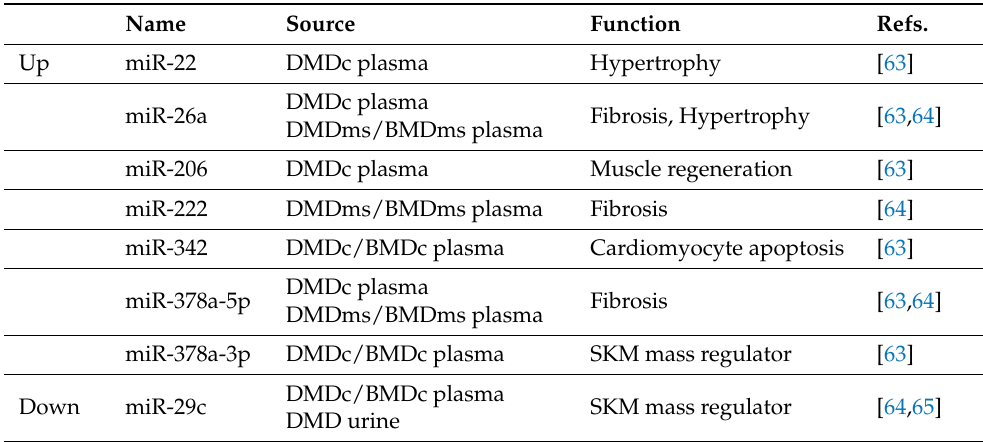
Table 4. Circulating miRNAs in DMD/BMD-associated